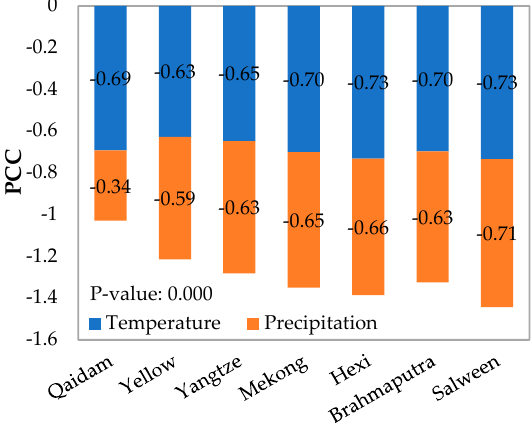
Figure 17. The Pearson correlation coefficients (PCCs) for the monthly NDSI and temperature/ precipitation from January 2001 to March 2017 in seven subregions.